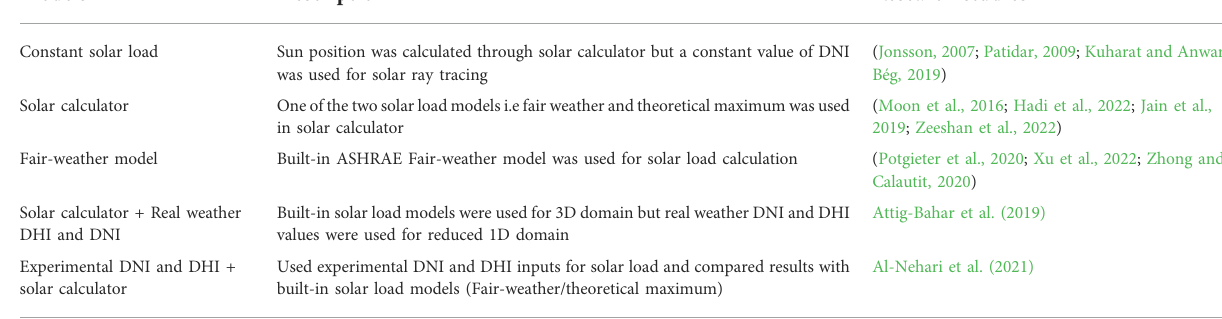
TABLE 1 Research studies that utilize solar load